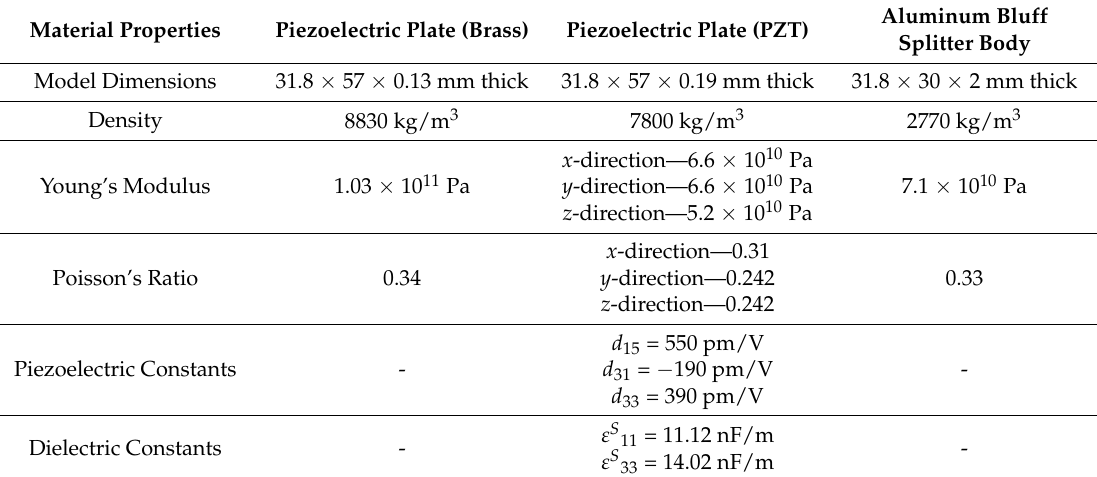
Table 1. Material properties of structural model.